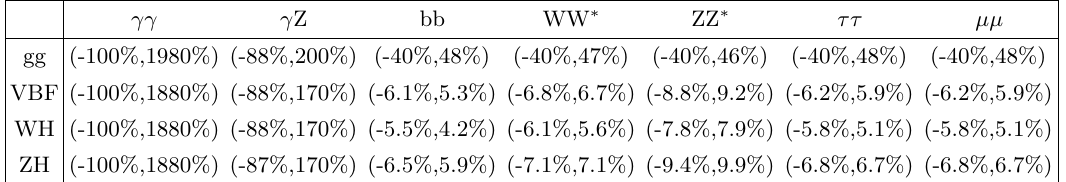
Table 9 . Possible deviations in signal strengths, due to top-quark operators, in major Higgs production and decay channels at the LHC. The top-quark operator coe(cid:14)cients are allowed to vary within the current constraints, described in table